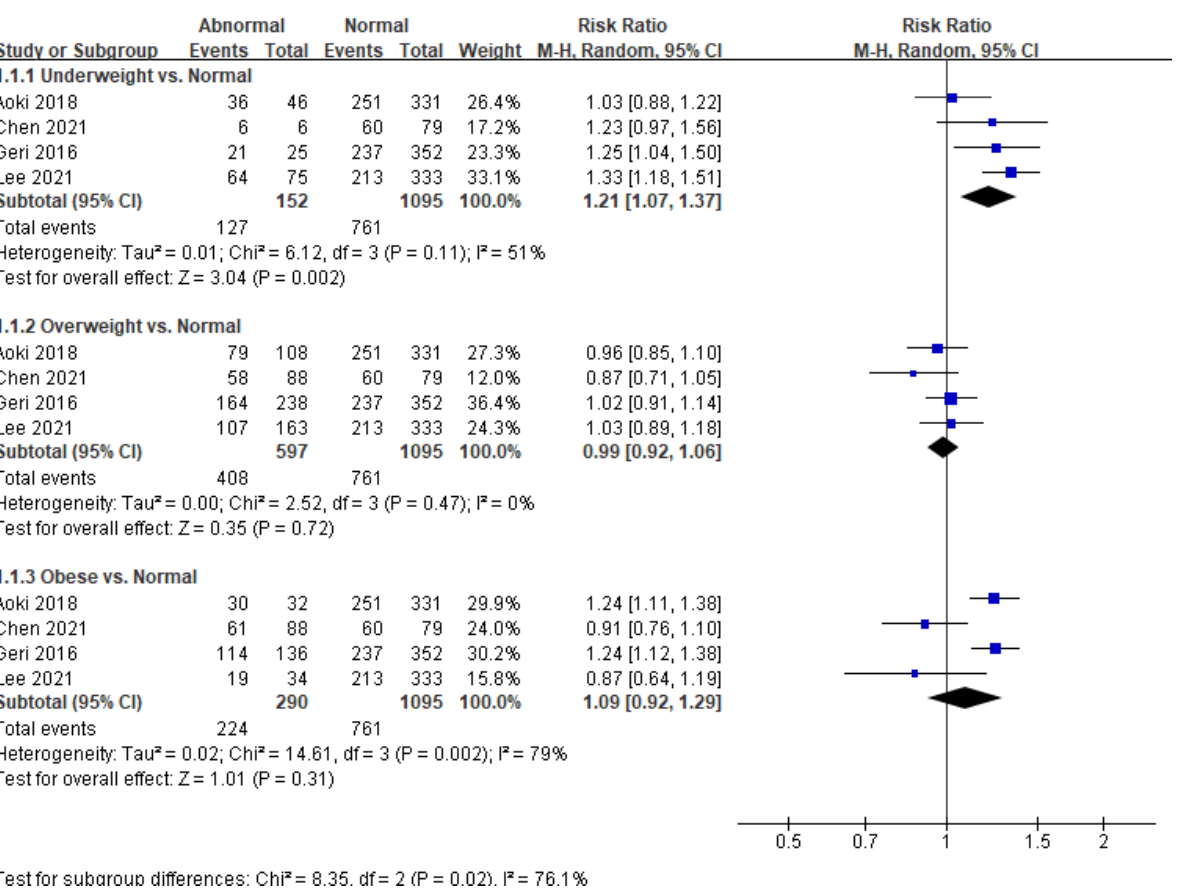
Figure 2. Forest plot of the association between body mass index categories and neurological outcomes in patients with return of spontaneous circulation after out-of-hospital cardiac arrest.